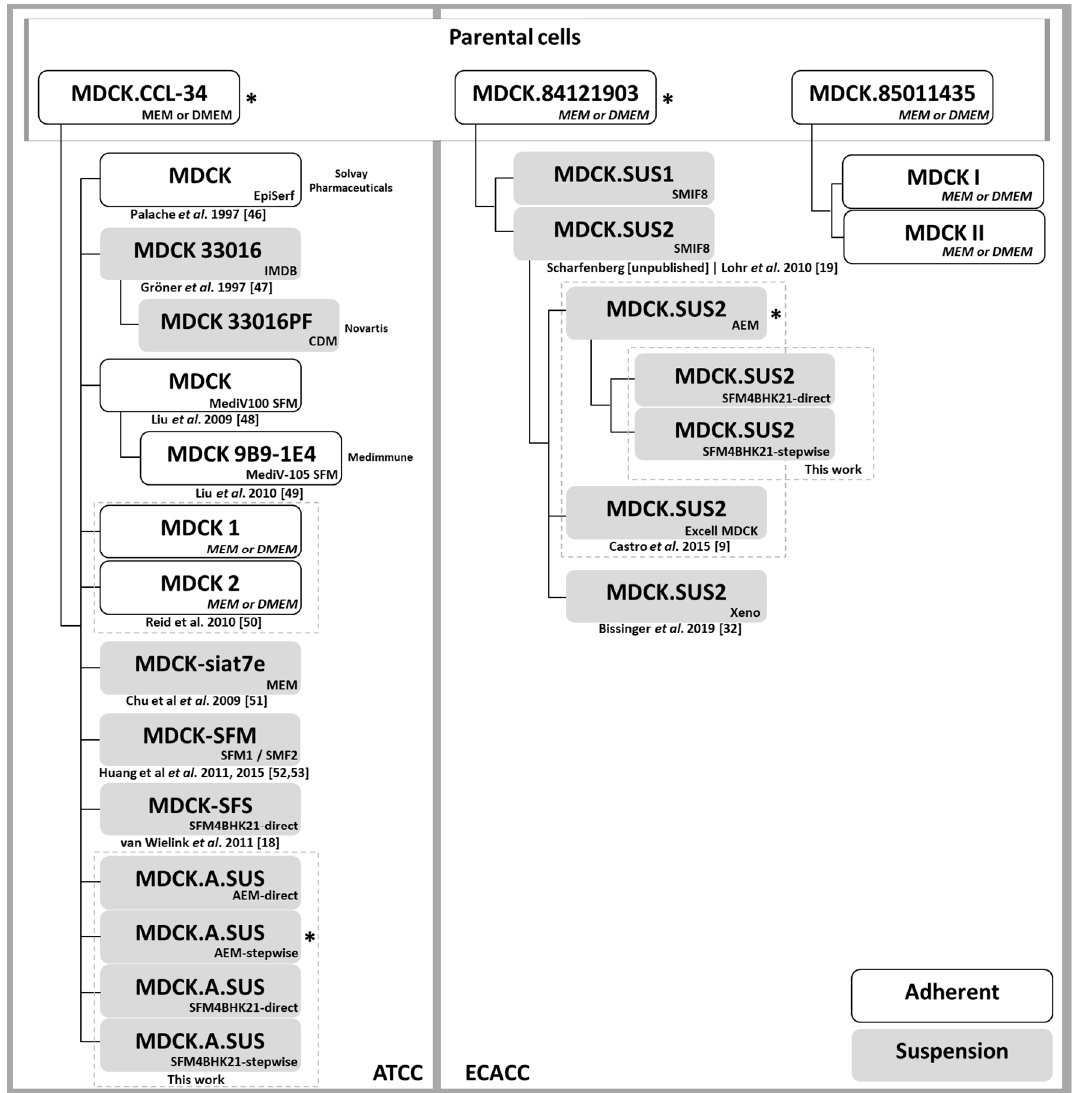
Figure A4. Derivations of MDCK parental cells from ATCC or ECACC cells for cell-cultured based bioprocesses. When that information was available, the use of these cells by pharmaceutical companies (typically for influenza virus production) is indicated. Medium formulation used in each case is indicated in each box on the bottom-right corner. The cells used in this work for transcriptome analysis are indicated with ‘*’ [9,19,32,46–53].